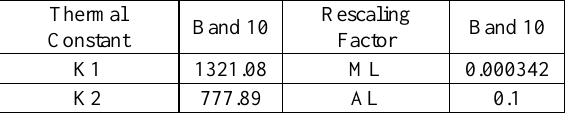
Table 6. Equations and Conditions for estimating LSE with